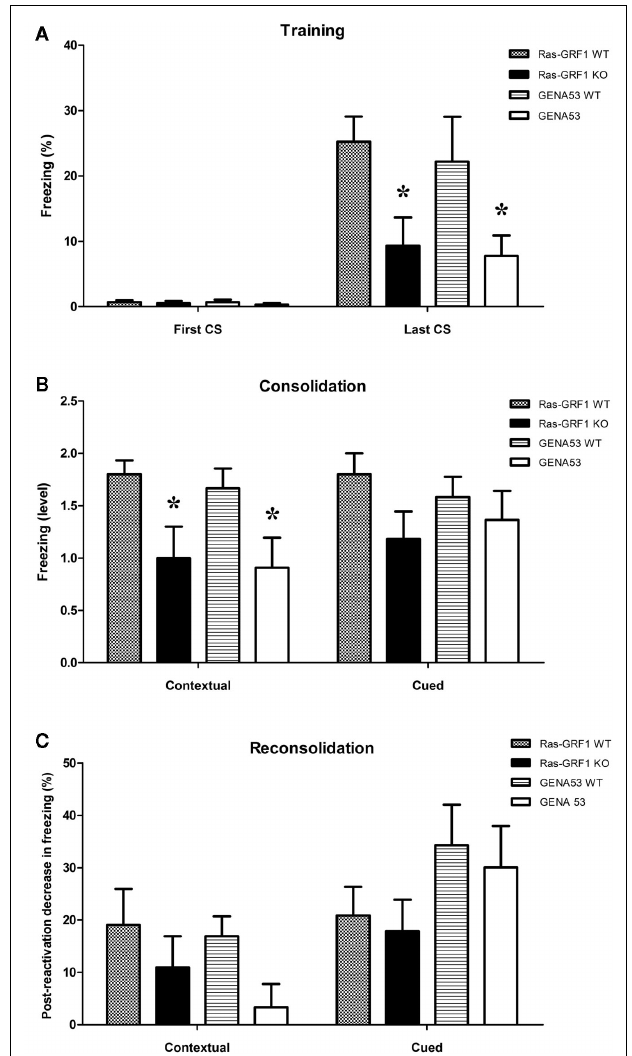
FIGURE 4 | Contextual and cued fear conditioning. Fear memory (means ± SEM) in the training (A) , test (B) , and re-test (C) phases. (A) Percentage of freezing at the beginning (first CS) and at the end (last CS) of the training. (B) Freezing level in the memory consolidation test (categorized by performance: 0 = non-learner; 1 = bad learner; 2 = good learner). (C) Decrease of freezing percentage in the memory reconsolidation test (percentage of freezing before reactivation minus percentage of freezing post-reactivation). Ras-GRF1WT ( n = 10); Ras-GRF1 KO ( n = 11); GENA53 WT ( n = 12); GENA53 ( n = 11). Each mutant is compared with its respective wild-type by means of a post hoc comparison. P -value symbols: black star = p < 0.001; black triangle = p < 0.01; asterisk = p <